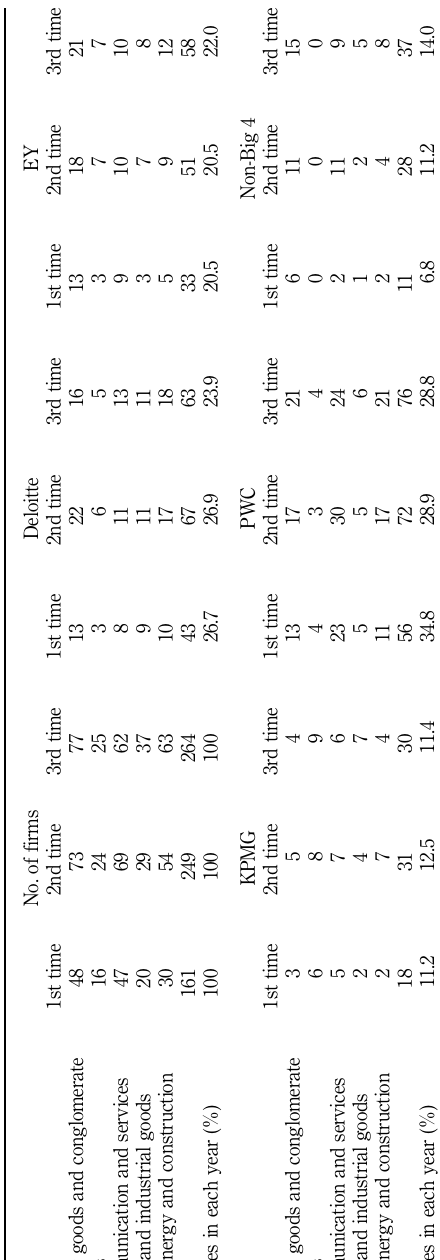
Table I. Number of firms audited by